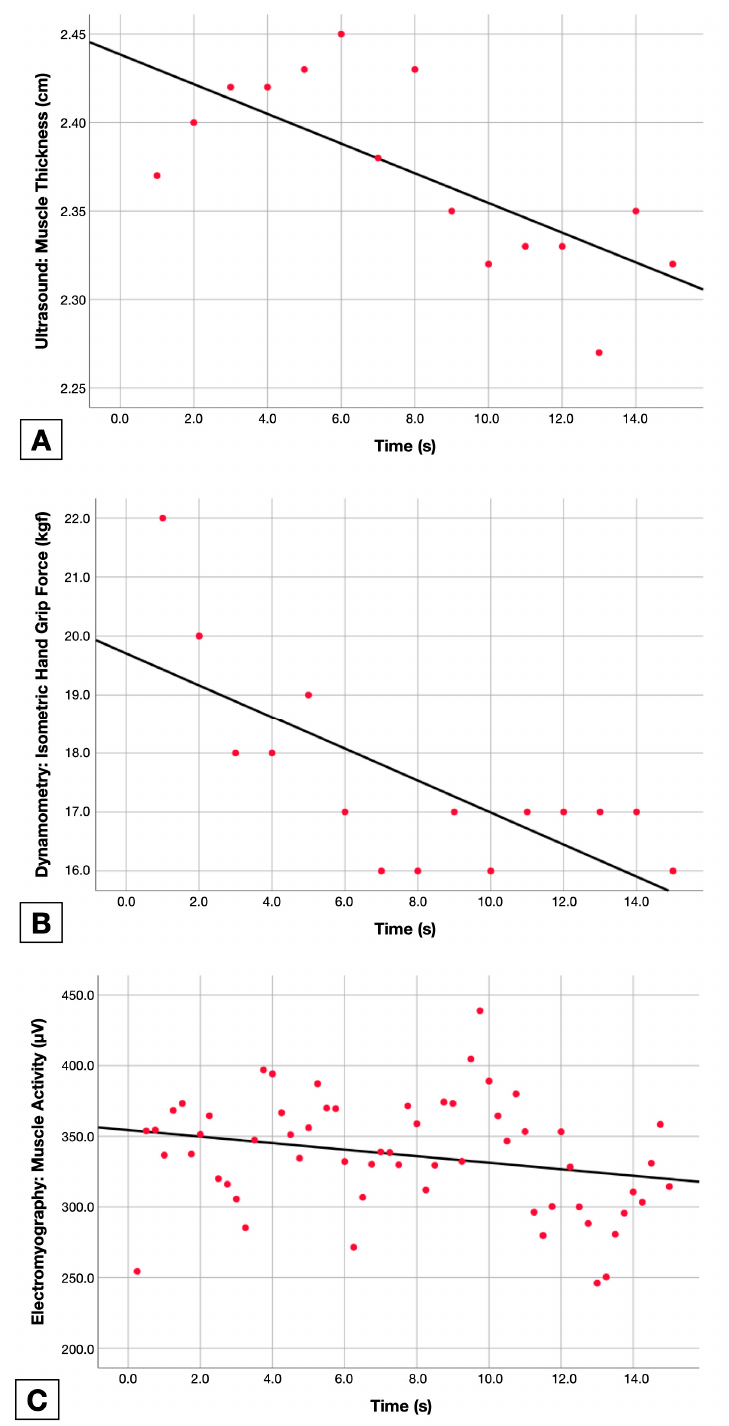
Figure 3. Fatigue measurement data points with adjusted line calculation using ultrasound imaging ( A ), Hand Grip Dynamometry ( B ) and electromyography ( C ). ( A ), Hand Grip Dynamometry ( B ) and electromyography ( C